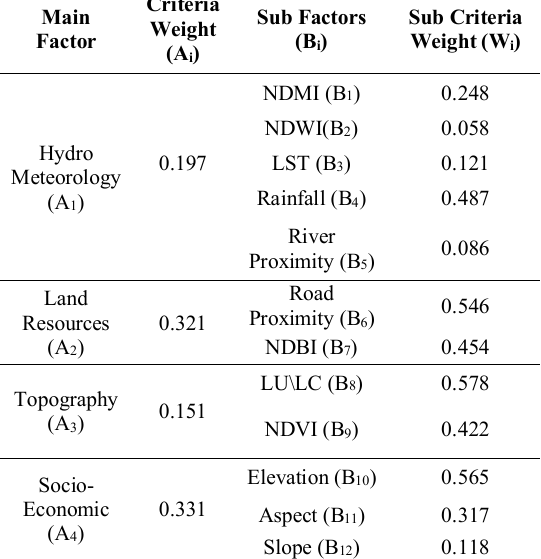
Table 3: Weightage for Factors and Sub